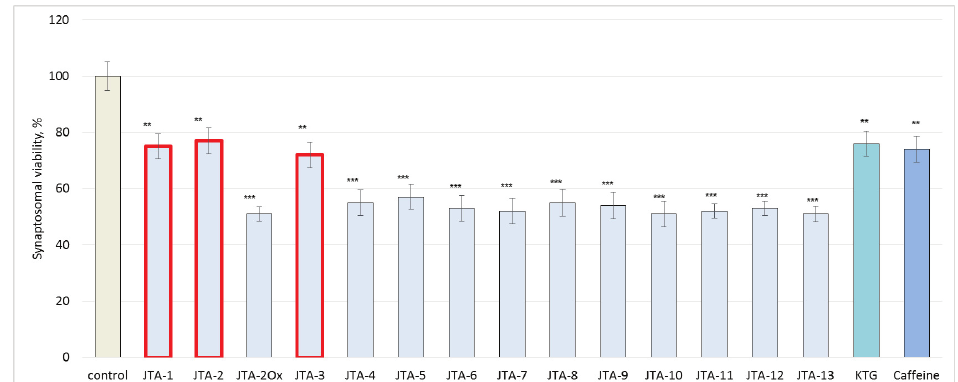
FIGURE 4 - Effects of caffeine-8-thioglycolic acid (KTG) derivatives, administered alone, on synaptosomal viability, measured by MTT-test. After 1 h of treatment with test substances synaptosomal viability is expressed as a percentage of a control (non-treated synaptosomes). Mean ± SEM (n = 6). ** P < 0.01; *** P < 0.001 – vs